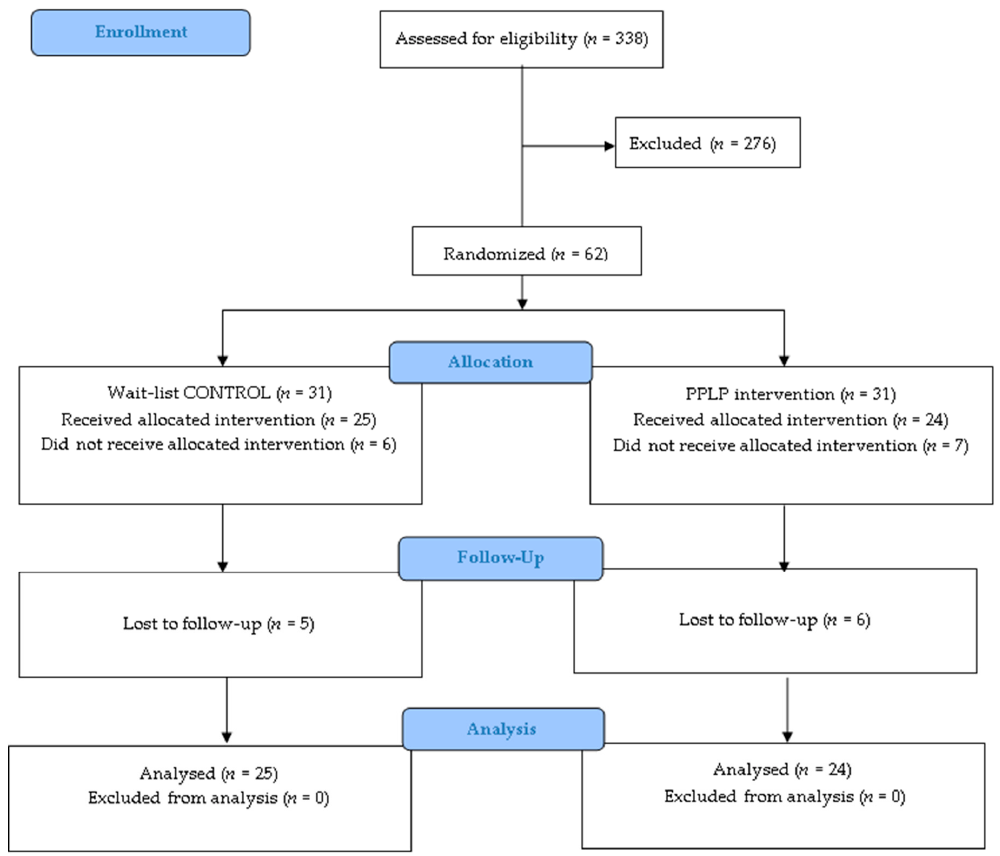
Figure 2. CONSORT flow diagram.